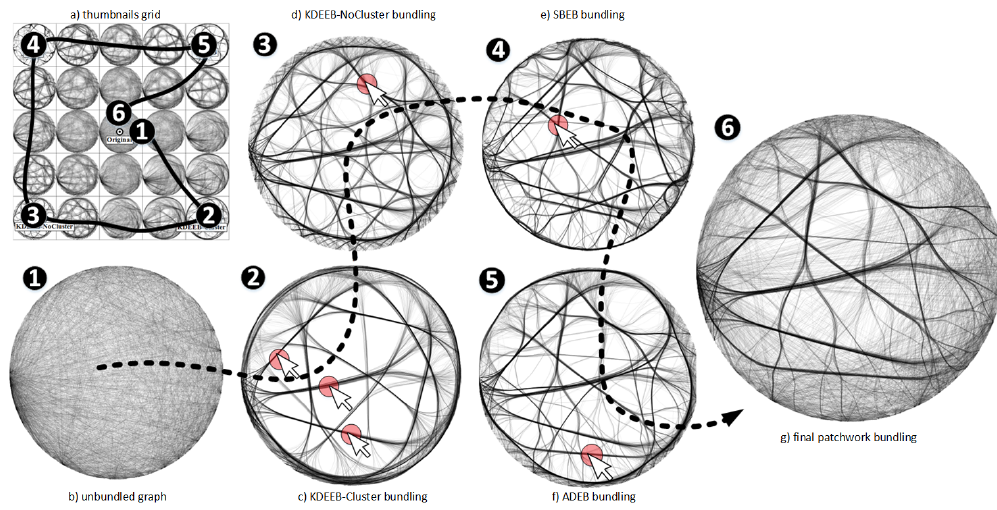
Figure 8. Extracting relevant structures from four types of bundling algorithms to create a new bundling view for a graph